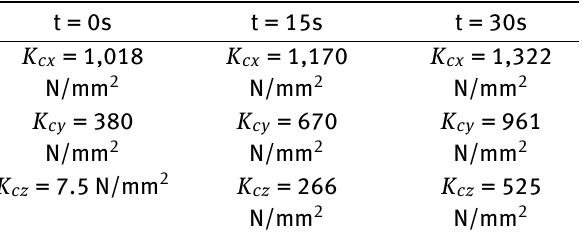
Figure 8: Tool wear of Al2O3+SiCw: new and worn tool (rake and relief faces views), at 250 m/min (up row) and 300 m/min (down row). Table 4: Cutting coeflcients at different stages of tool wear.